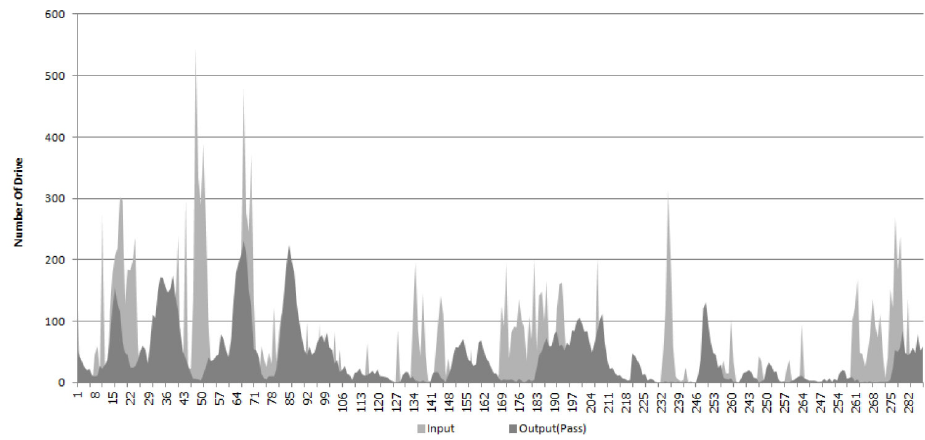
Figure 6. Drive input numbers and output (pass) numbers for each hour